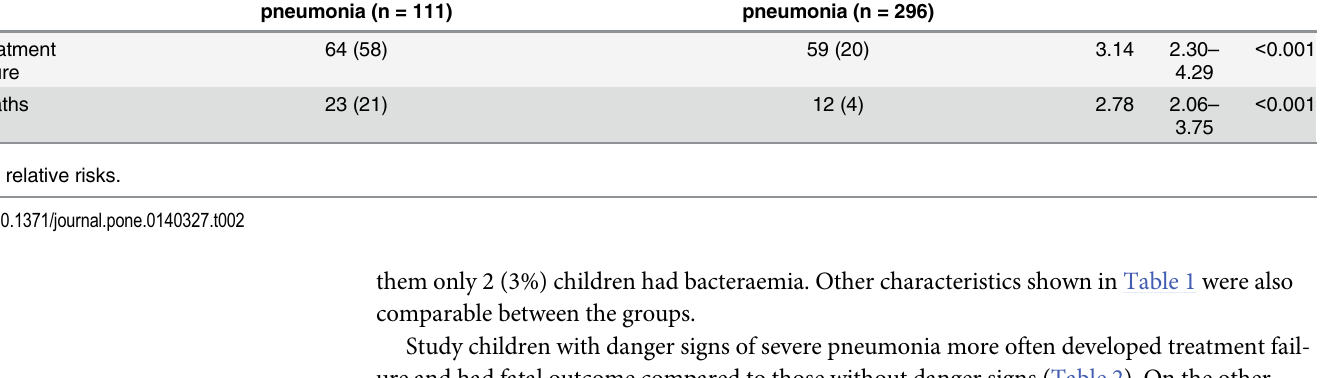
Table 2. Outcome of the World Health Organization recommended interventions in hospitalised, severely malnourished, under-five children with danger signs of severe pneumonia and those without danger signs of severe pneumonia. Characteristic